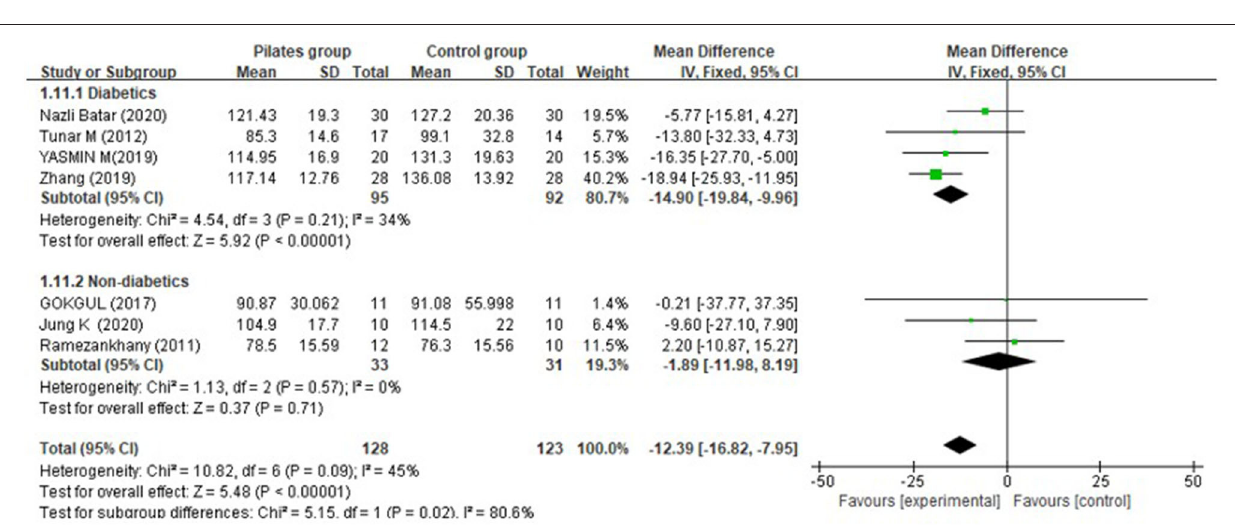
FIGURE 10 | Meta-analysis and forest plot for low-density lipoprotein